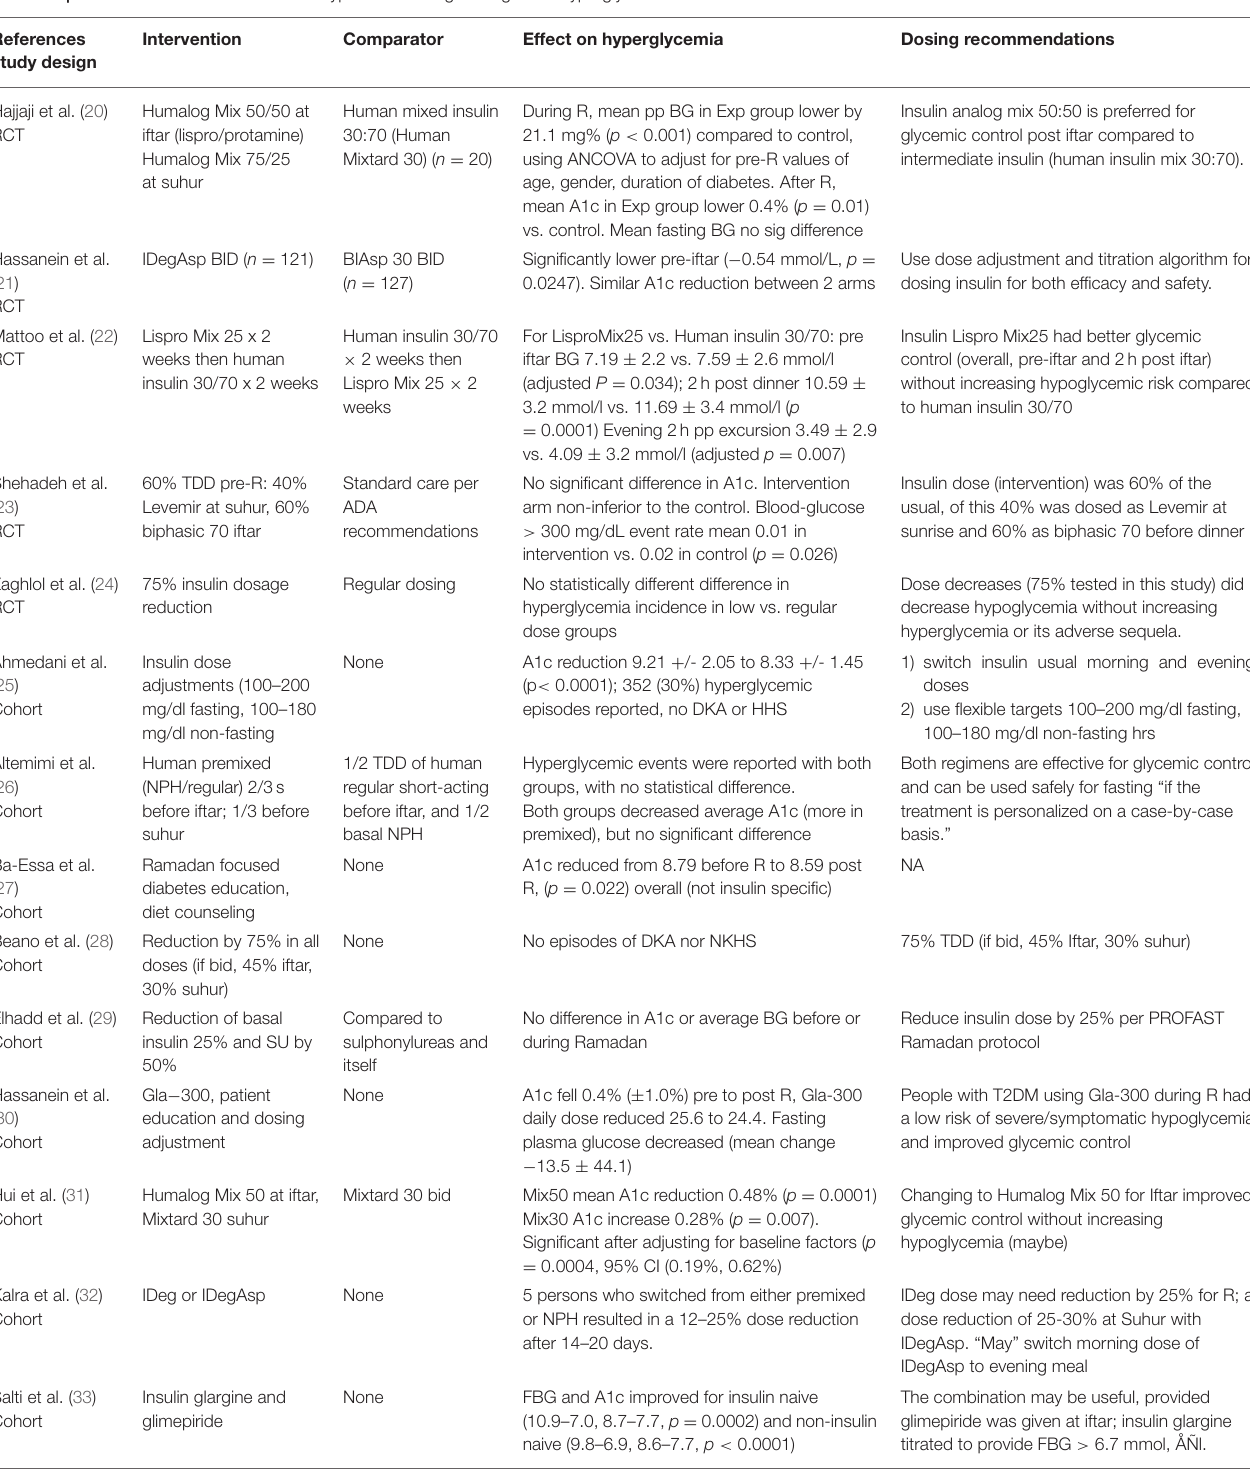
TABLE 4 | The effects of different insulin subtypes and dosing strategies on hyperglycemia. References study